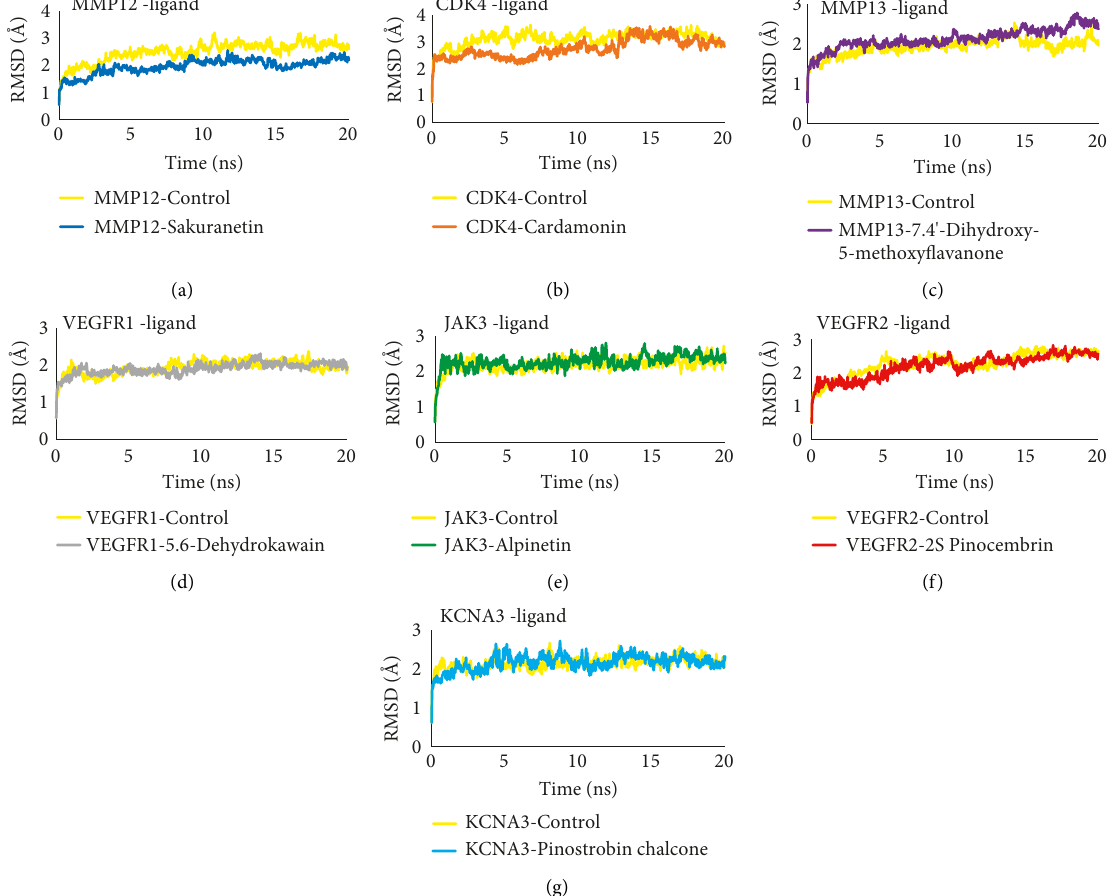
Figure 4: Root mean square deviation (RMSD) of the protein-compound